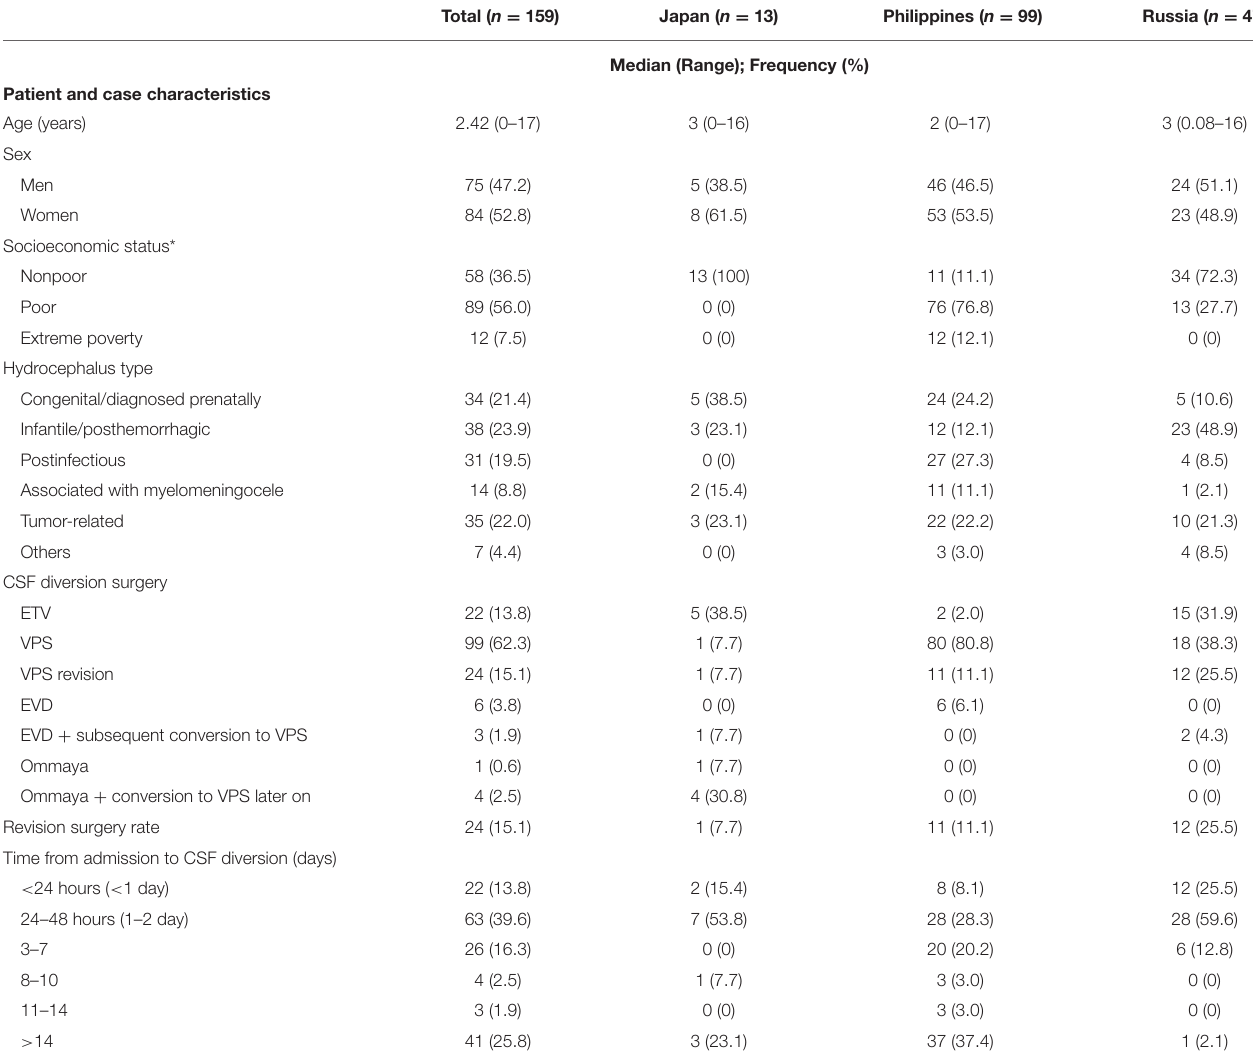
TABLE 1 | Clinical and socioeconomic characteristics of the patients. Total ( n = 159) Japan ( n = 13) Philippines ( n = 99) Russia ( n =